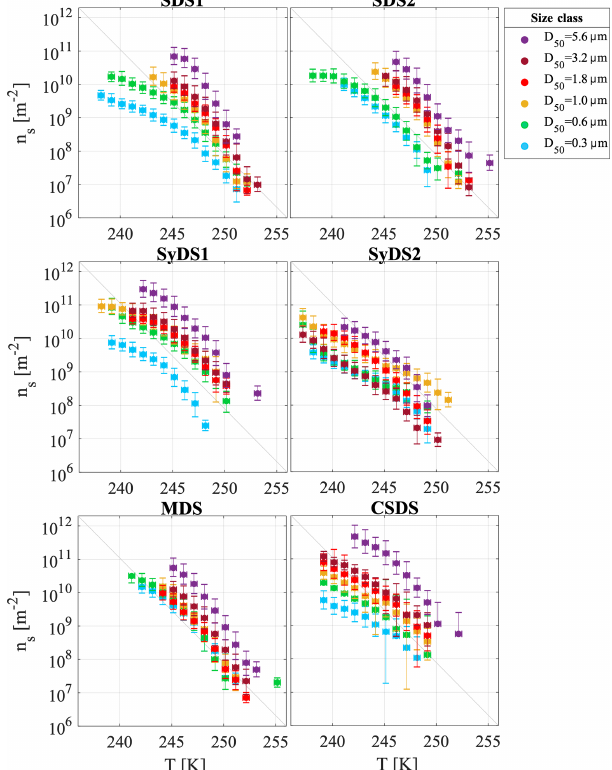
Figure 6. Ice-active site density as a function of temperature, n s (T ) , for airborne particles dominated by mineral dust are pre- sented individually for each dust event. The different colors repre- sent the different size classes that were investigated. SDS, SyDS and MDS represent Saharan, Syrian and mixed dust events, respectively (see text for more details). The linear grey line is identical in each panel to facilitate